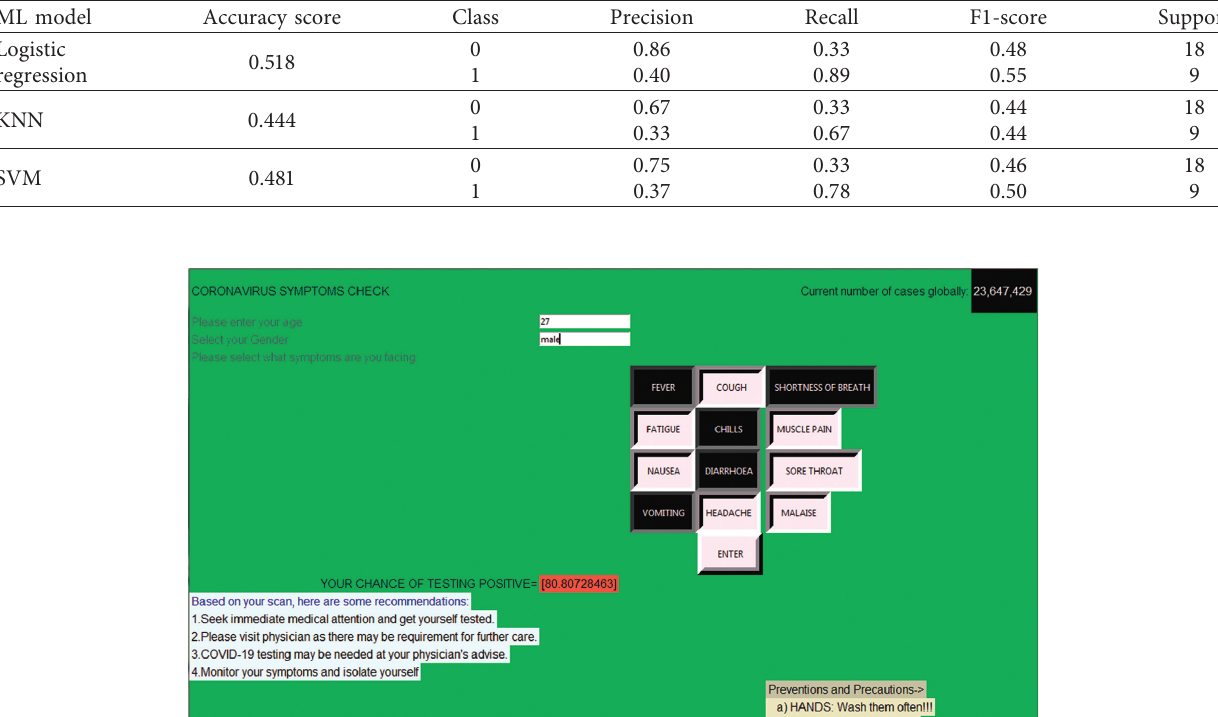
Table 4: Performance evaluation for machine learning models.